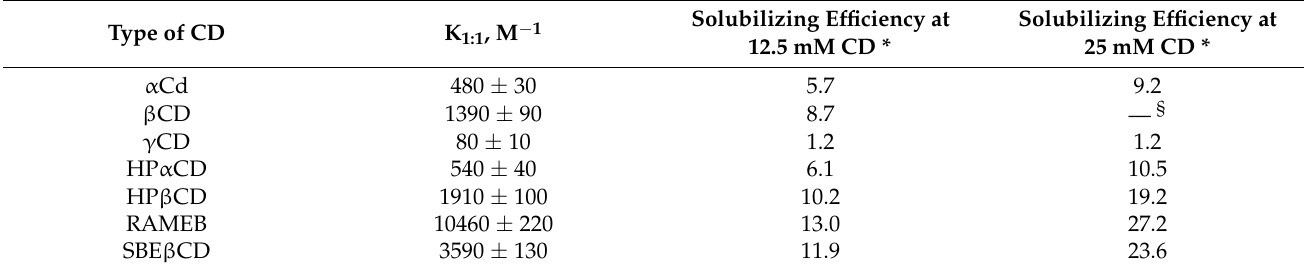
* ratio between drug solubility in the presence of a given CD concentration, and solubility of drug alone (0.86 mM); § not determinable ( β CD solubility < 25 mM).